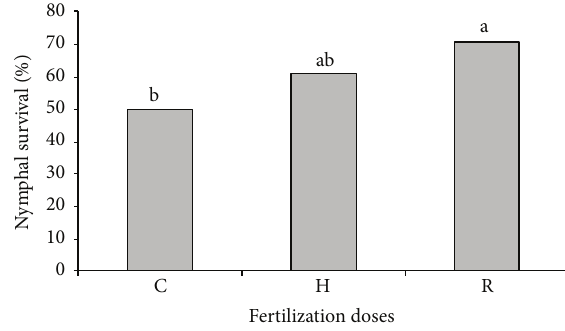
Figure 1: Mahanarva spectabilis nymph survival (%) kept in B. ruz- iziensis cultivated under recommended (R), half of recommended (H), and control (C)fertilization. Means values followed by the same letter did not differ among them by the Tukey test ( 𝑃 < 0.05